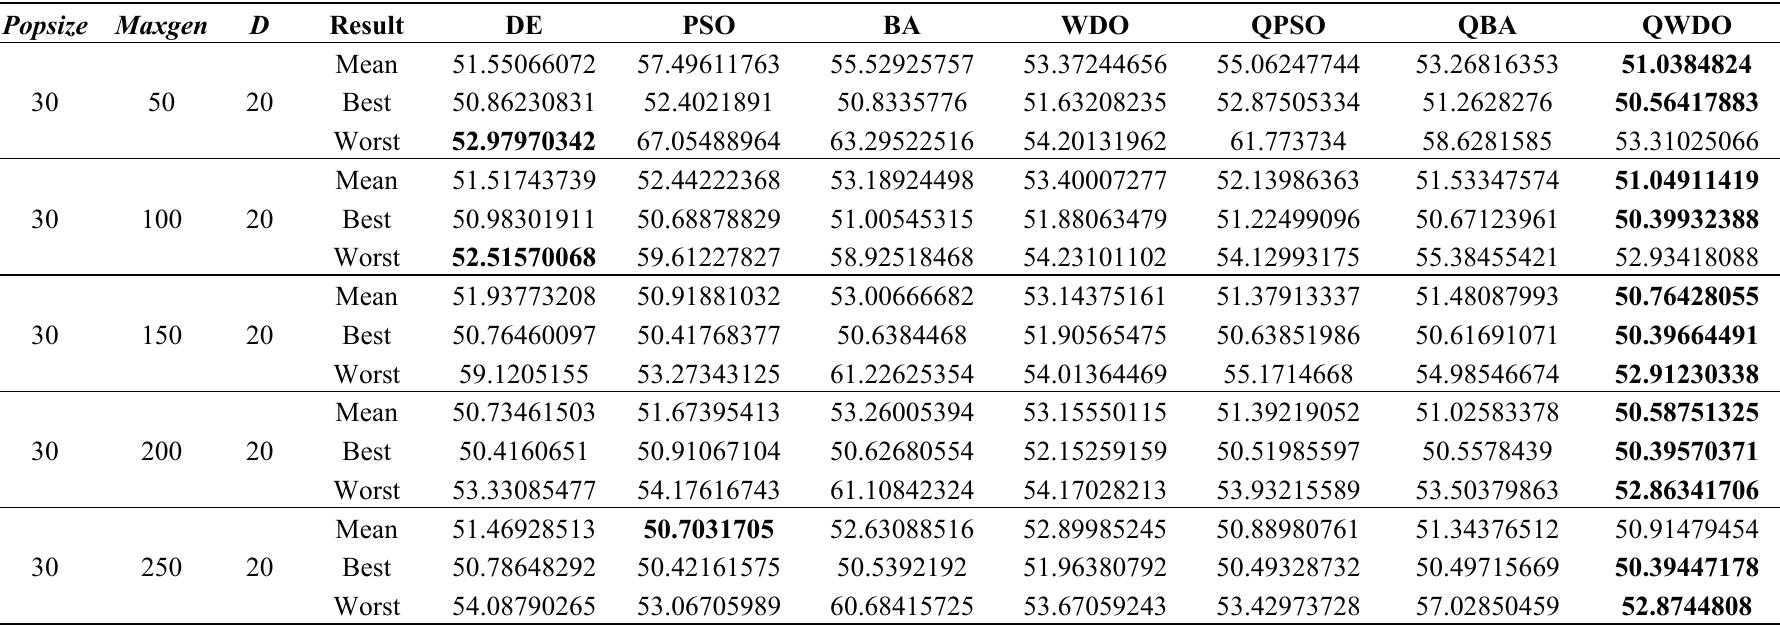
Table 10. Experimental results for the first test instance in different Maxgen .